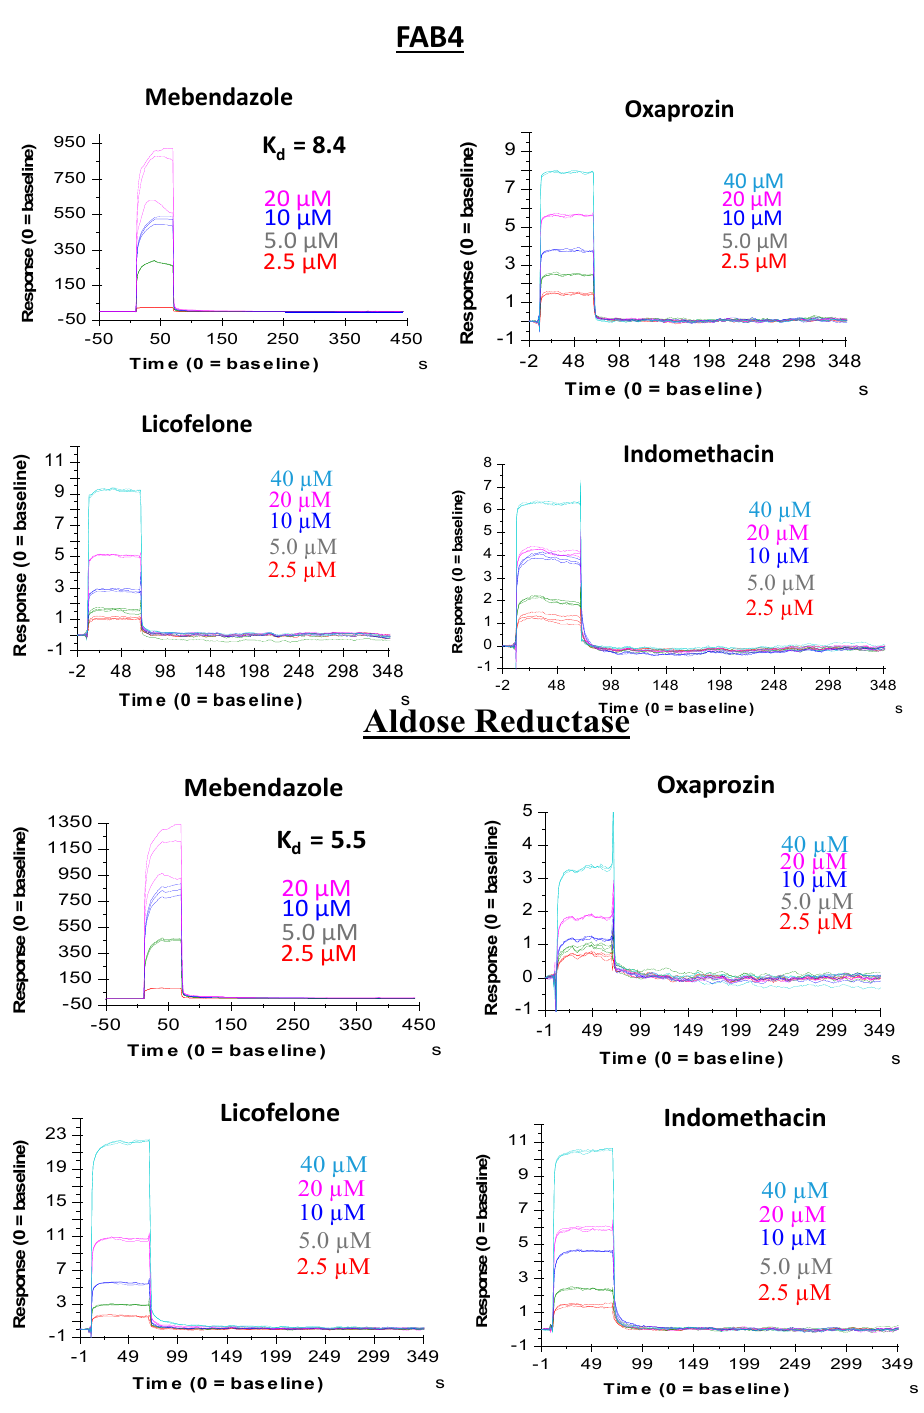
Figure 8. Mebendazole, Indomethacin, licofelone, and oxaprozin bind directly, in a dose-dependent manner, to immobilized human adipocyte fatty acid binding protein (FABP4) and aldose reductase (AKR1B1) in Surface Plasmon Resonance (SPR) assay. Assays were performed in triplicates for each drug with respect to each protein target.